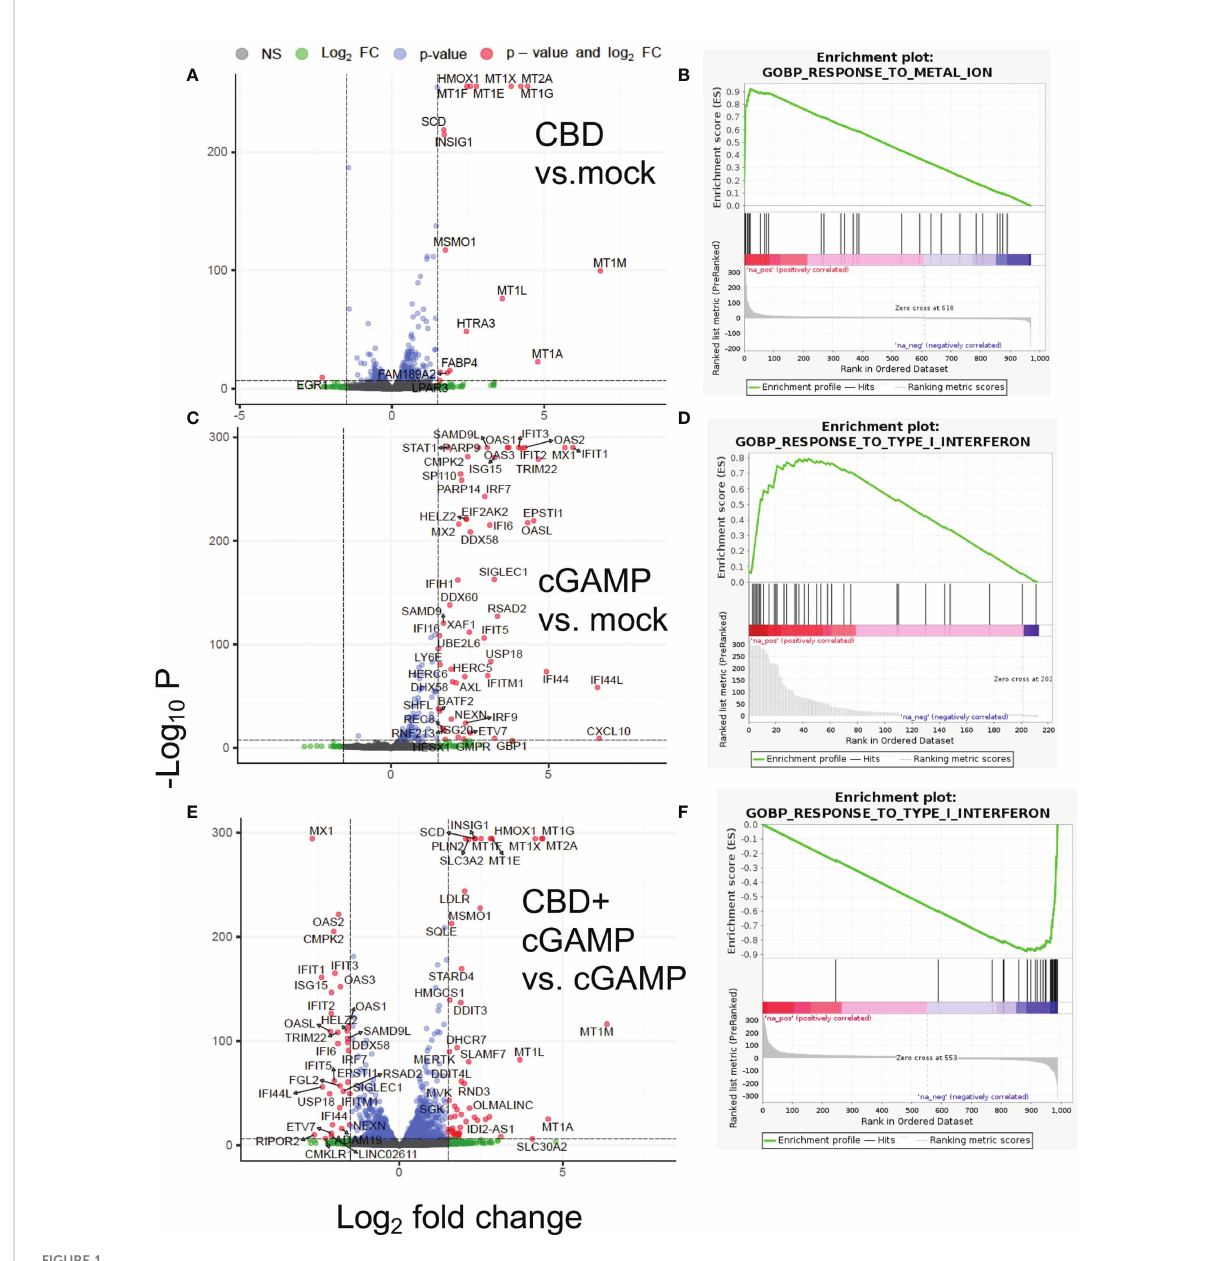
FIGURE 1 Differential gene expression and gene set analysis of RNA-seq data. THP-1 cells were treated with vehicle or 10ug/ml CBD and co-stimulated with 2 ’ 3 ’ -cGAMP for 8 hours. Afterwards, we extracted RNA for transcriptomics analysis through RNA-seq. Volcano plot and gene set analysis comparing CBD treatment alone to mock (A, B) , 2 ’ 3-cGAMP treatment alone to mock (C, D) , 2 ’ 3 ’ -cGAMP and CBD cotreatment compared to 2 ’ 3 ’ -cGAMP treatment alone (E, F)